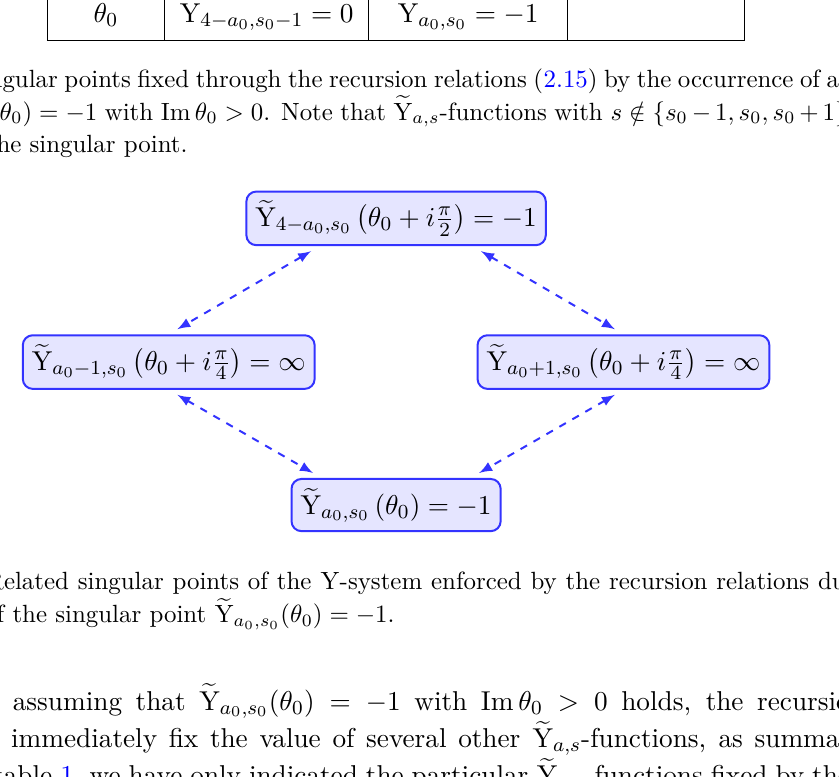
0 . Note that e Y -functions with s / ∈ { s 0 > a,s